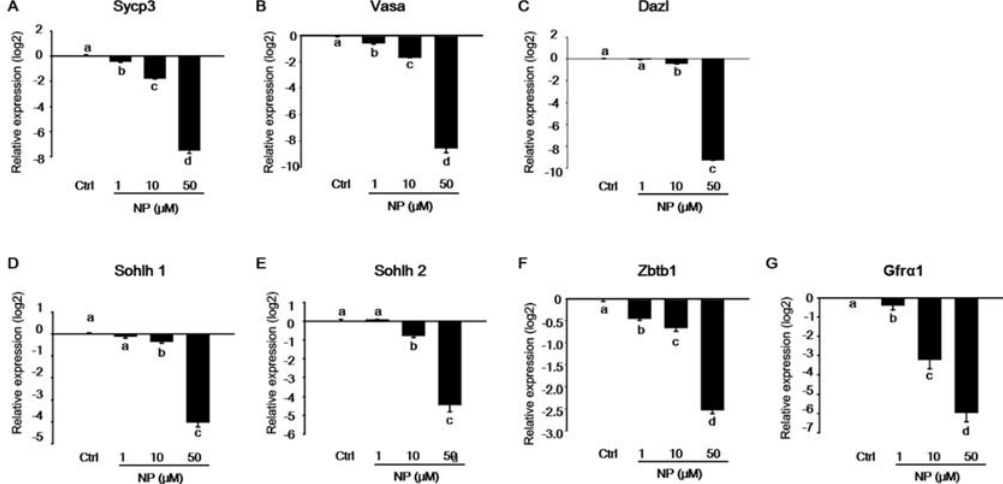
Figure 2. Expression of germ cell markers in 30 ‐ day cultured mouse testicular fragments (MTFs). The mRNA levels of the germ cell markers ( A ) Sycp3 , ( B ) Vasa , ( C ) Dazl, ( D ) Sohlh1, ( E ) Sohlh2 , ( F ) Zbtb16 , and ( G ) Gfra1 in the MTFs were determined using quantitative polymerase chain reaction. The relative quantification of mRNA is shown using the mean and the standard error of the mean ( n = 6) at log 2 scale. The levels of undifferentiated and differentiated germ cell markers distinctly decreased in a dose ‐ dependent manner in 30 ‐ day cultured MTFs with nonylphenol (NP).